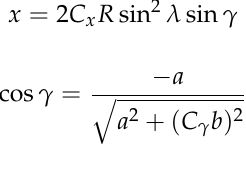
Table 1. Parameters of the proposed model.